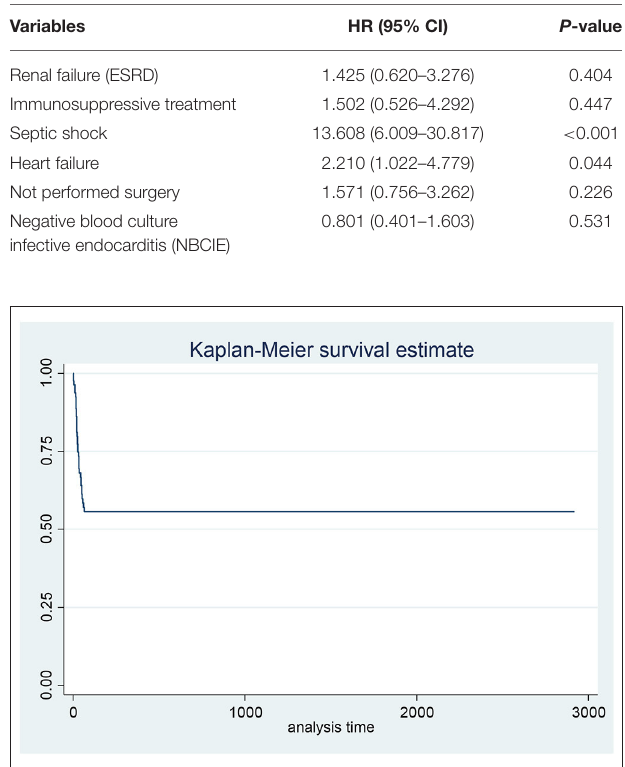
TABLE 5 | Univariate Cox proportional hazard model.